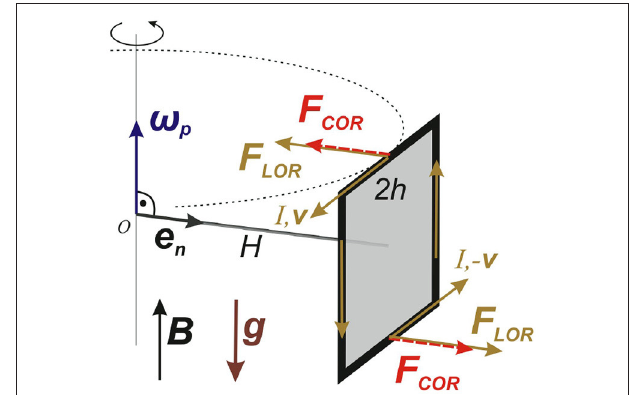
FIGURE 7 | (color online) Square wheel model where the chain/fluid flow having velocity v carries an additional electric current I . The system is placed in a combined magnetic B and gravitational g field, and investigated from the reference frame precessing with ω p . Besided the Coriolis forces F COR , Lorentz forces F LOR also contribute to the canceling of the gravitational torque (see section